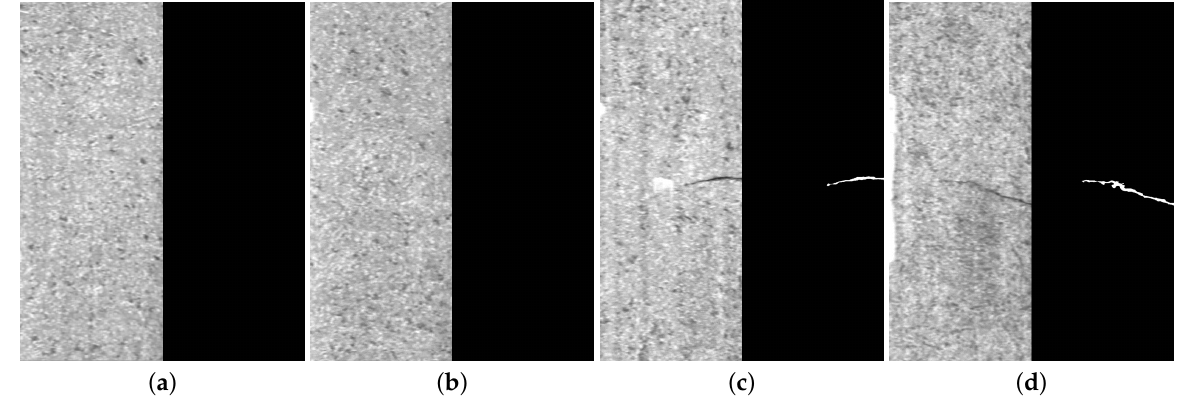
Figure 7. Example images of KolektorSDD. ( a , b ) are the raw images without defects and its ground truth; ( c , d ) are the raw images with defects and their ground truth.